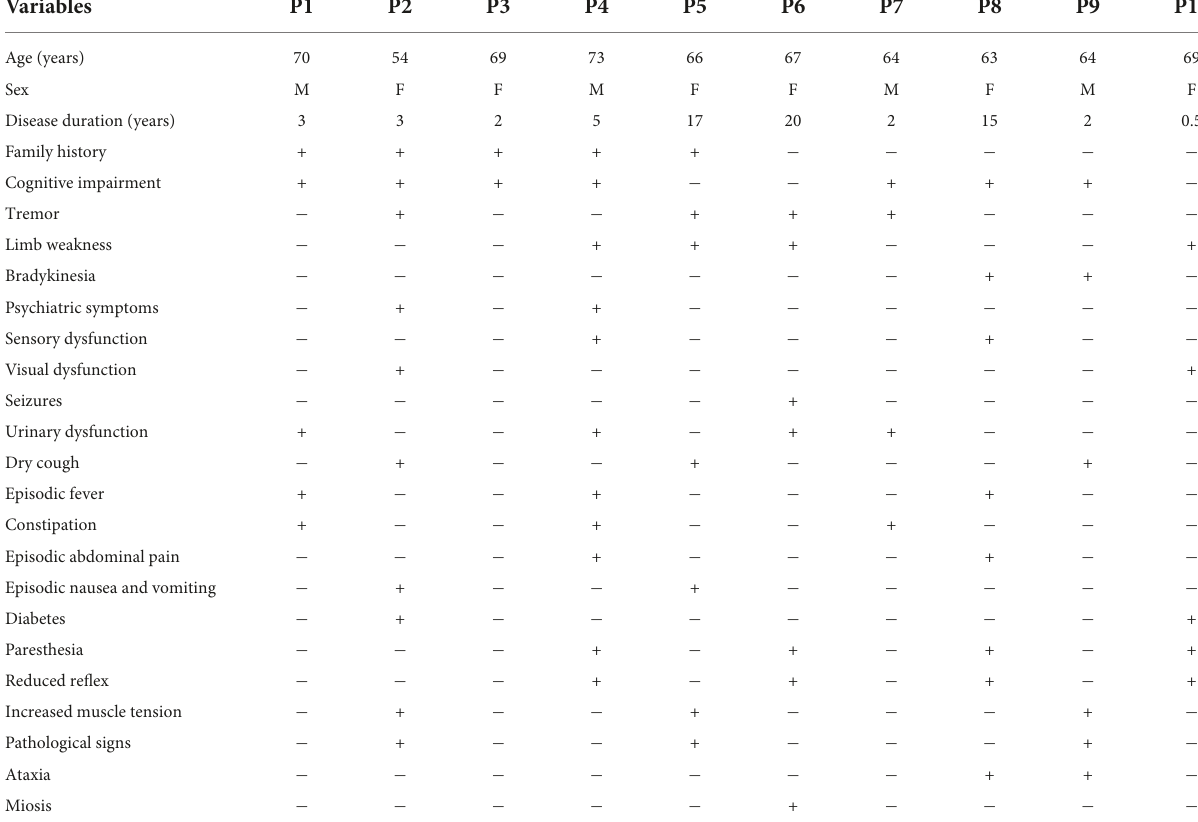
TABLE 1 Clinical data of 10 patients with neuronal intranuclear inclusion disease (NIID).